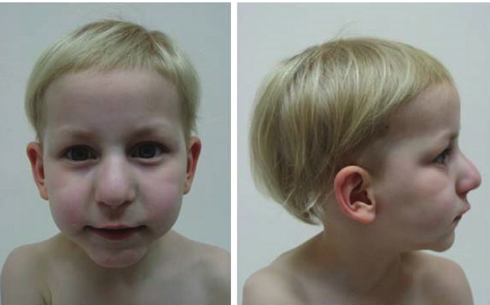
Figure 1: A 4-year-old girl presenting typical craniofacial TRPS features: fine hair, a bulbous nose, long philtrum, thin lips, and a receding chin.